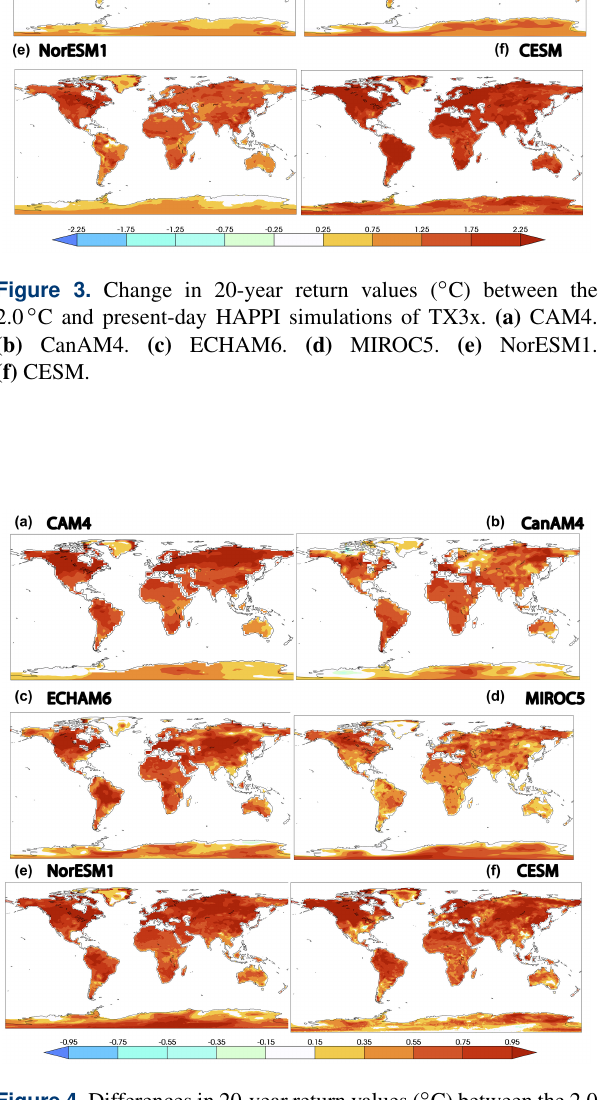
Figure 4. Differences in 20-year return values ( ◦ C) between the 2.0 and 1.5 ◦ C HAPPI simulations of TX3x. (a) CAM4. (b) CanAM4. (c) ECHAM6. (d) MIROC5. (e) NorESM1. (f) CESM. Note that the color scale covers a smaller range of temperature differences than for the previous